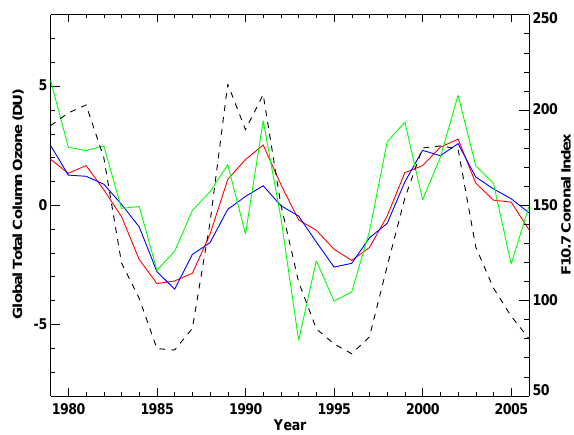
Fig.22. Annualmean, globalmeantimeseriesofthetotalcolumn O 3 regressionfitconsistingoftheF10.7index Fig. 22. Annual mean, global mean timeseries of the total column O 3 regression fit consisting of the F10.7 index term and the residual term and the residual term for the solar variability ensemble without EPP (red), the solar variability ensemble term for the solar variability ensemble without EPP (red), the so- with EPP (blue) and observed total column ozone data from Fioletov et al. (2002) (green). The F10.7 index is lar variability ensemble with EPP (blue) and observed total column also shown (dashed). ozone data from Fioletov et al. (2002) (green). The F10.7 index is also shown